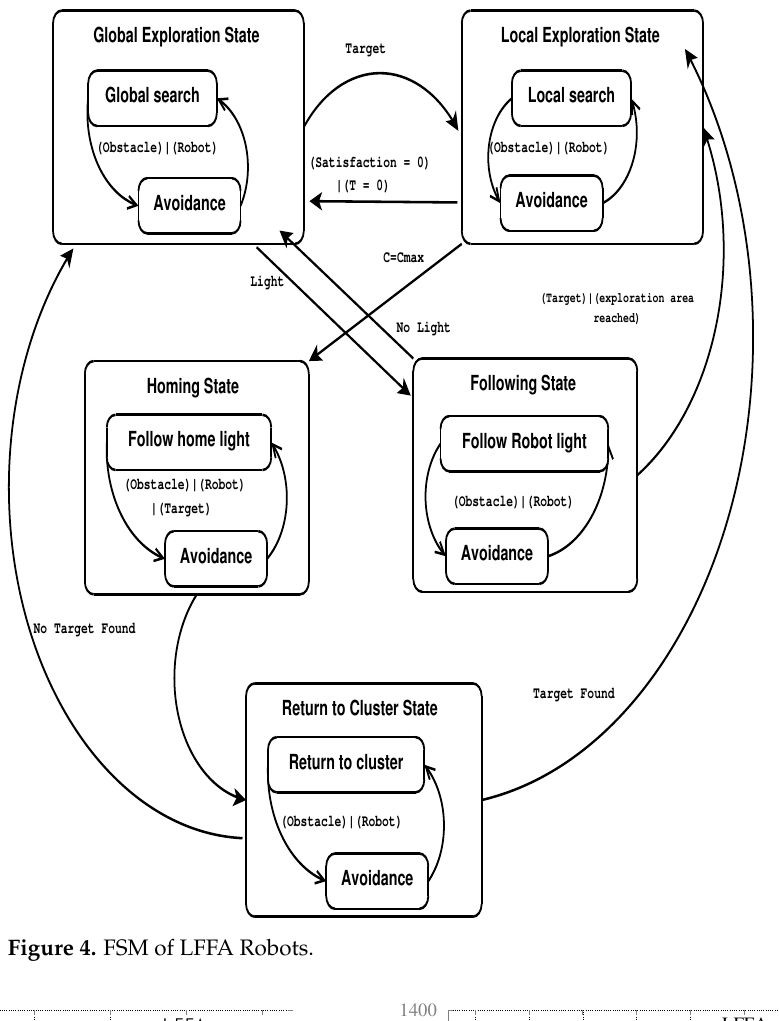
Figure 4. FSM of LFFA Robots.